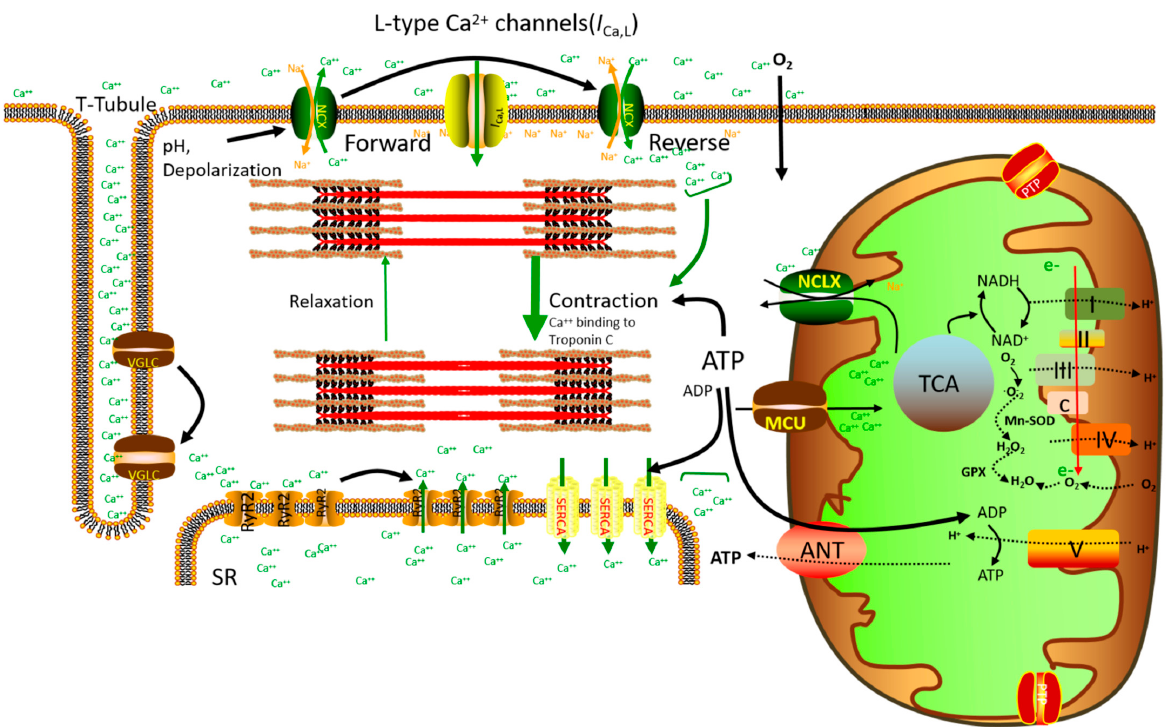
Figure 1. Under physiological conditions, Ca 2+ regulates excitation–contraction coupling, mitochon- drial energetics, and ROS production in cardiomyocytes. In cardiomyocytes, action potential causes Ca 2+ to enter cells from L-type Ca 2+ channels (Ica, L), and the influx of Ca 2+ activates Ryanodine Type